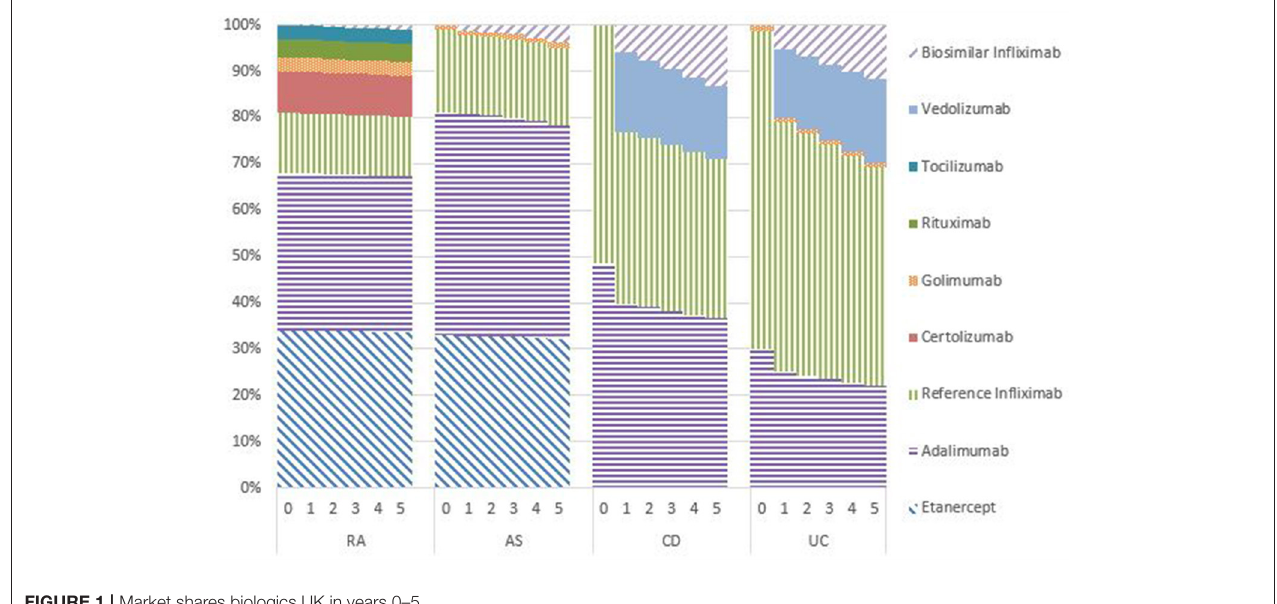
FIGURE 1 | Market shares biologics UK in years 0–5.